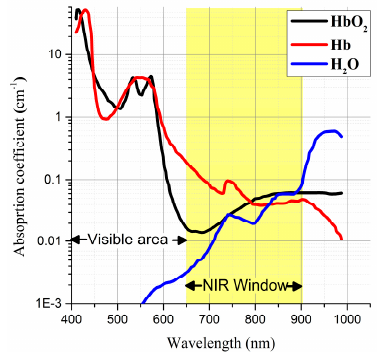
Figure 2. Absorption coefficients of H 2 O, HbO 2 , and Hb with respect to the wavelength [31].